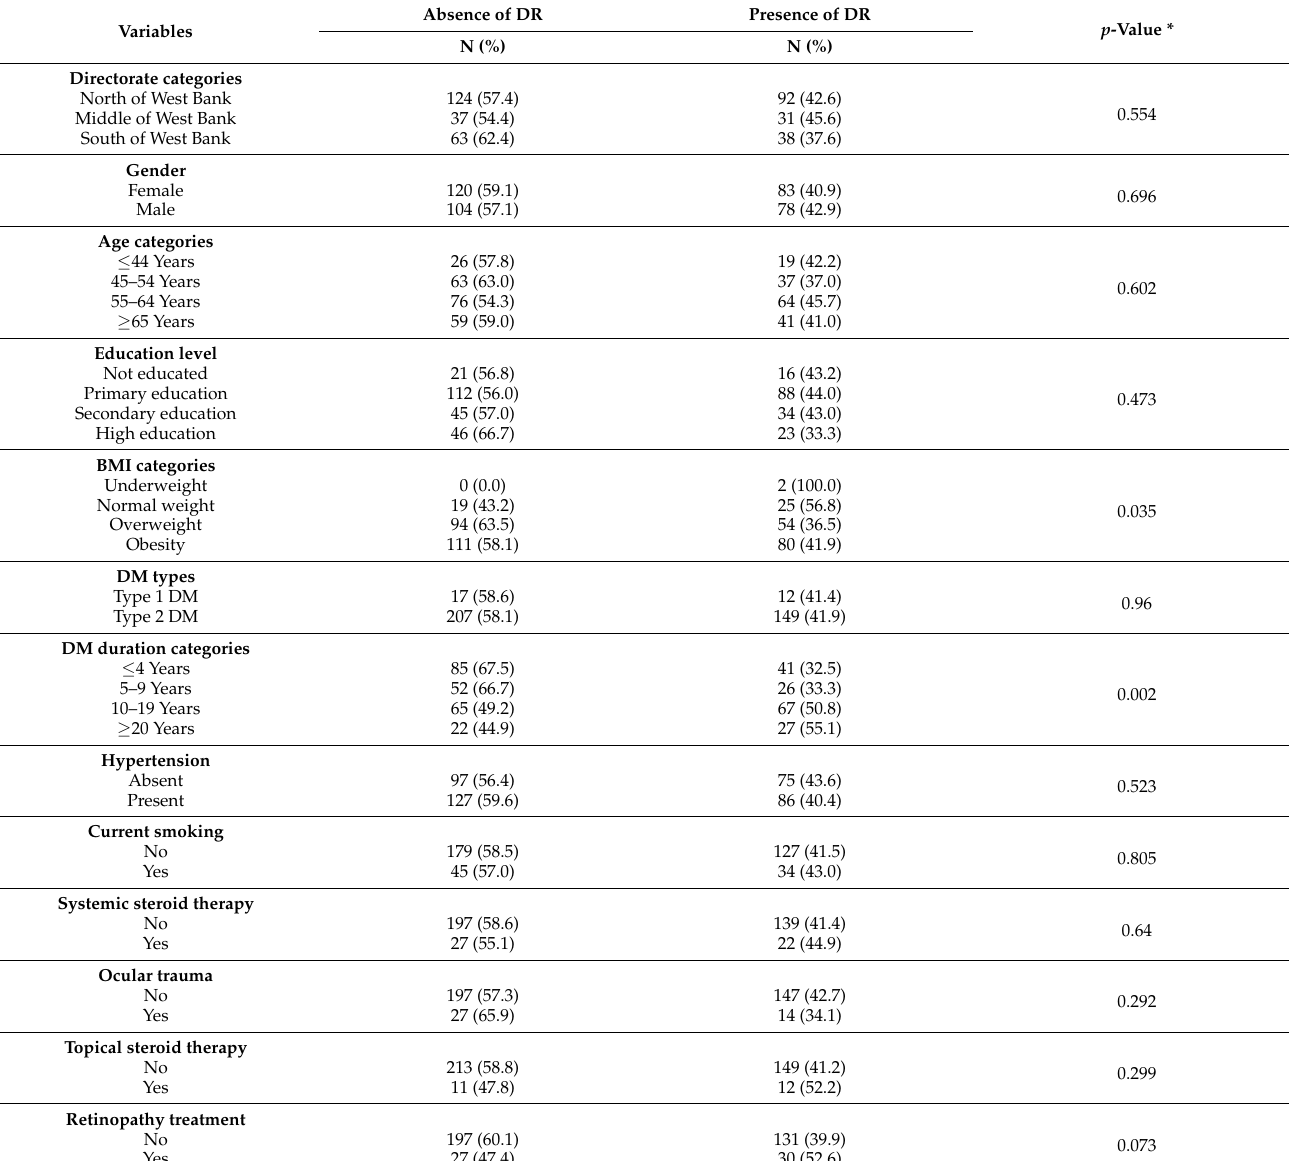
Table 1. Univariate analysis of the socio-demographic, medical, and ocular characteristics of dia- betic